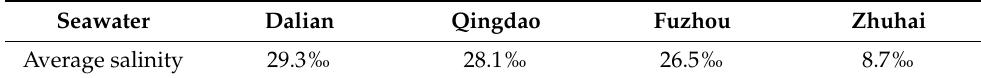
Table 1. Average salinity of the filtered seawater for shear strength test.